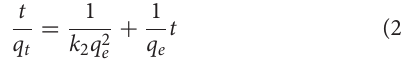
Frontiers in Water |